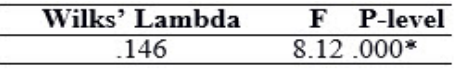
Table 1. Multivariate analysis of vari